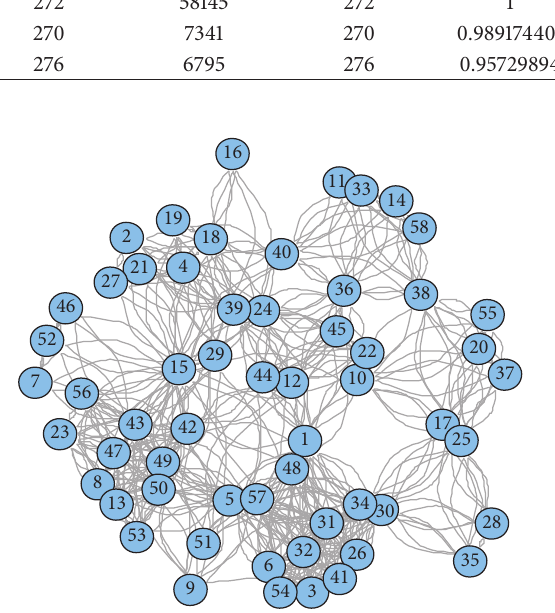
Figure 6: Dengue network projection of clusters in